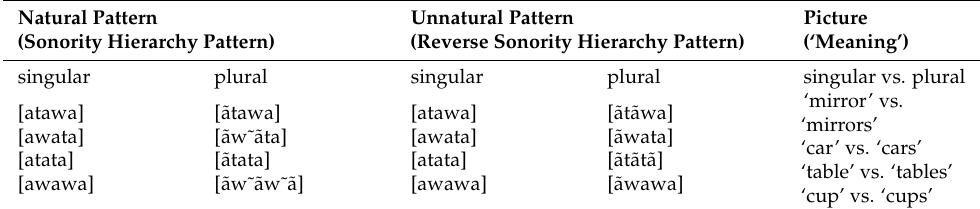
Table 5. One set of designs for exposure stimuli for trained groups.